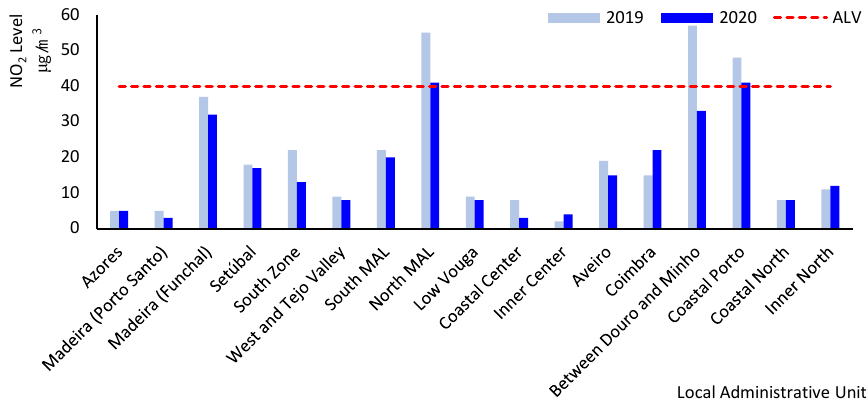
Figure 1. Evolution of NO 2 in different Portuguese regions (2019–2020). Source: authors’ creation based on data available from [16].